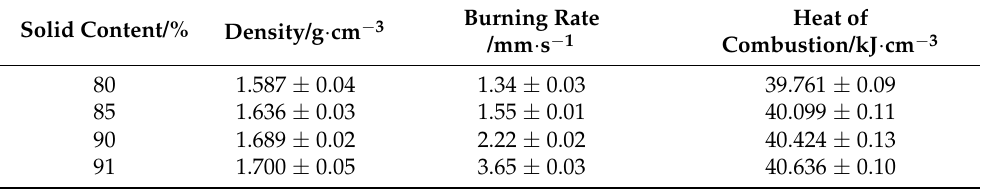
Table 3. Density, burning rate and heat of combustion of samples with different solid content.